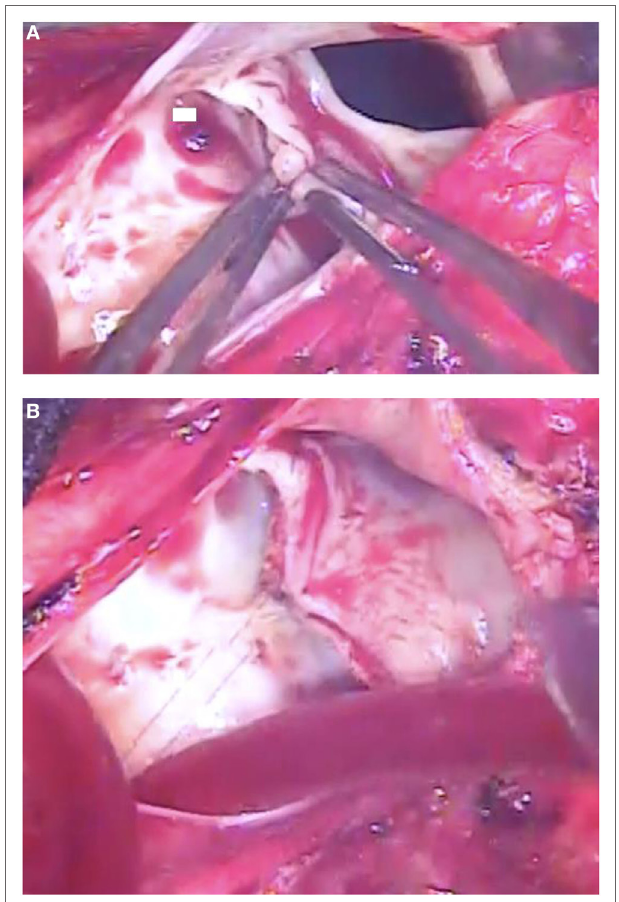
FIGURe 2 | (a) Intra-operative photograph showing the anterior leaflet of the pulmonary valve without any attachment to the annular hinge, while the other two leaflets are controlled with forceps. (B) Intra-operative photograph showing the anterior leaflet of the pulmonary valve reattached to the annulus with running suture.